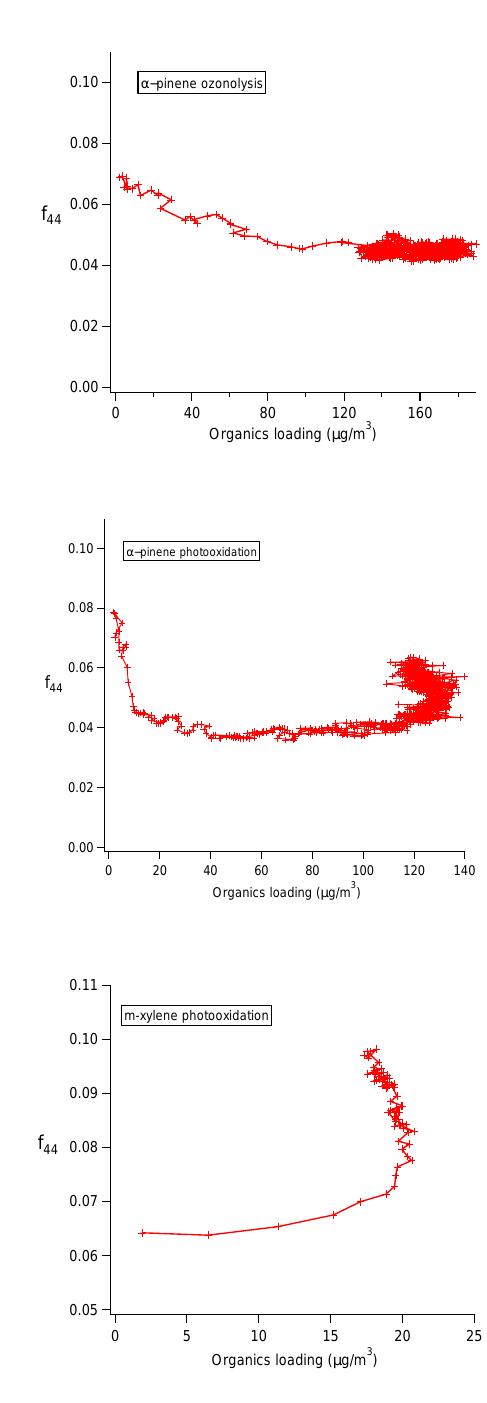
Fig. 9. (a) : Change in f 44 as a function of organics loading over the course of a typical α -pinene ozonolysis experiment. (b) : Change in f 44 as a function of organics loading over the course of a typical α -pinene photooxidation experiment (low-NO x ). (c) : Change in f 44 as a function of organics loading over the course of a typical m -xylene photooxidation experiment (low-NO x